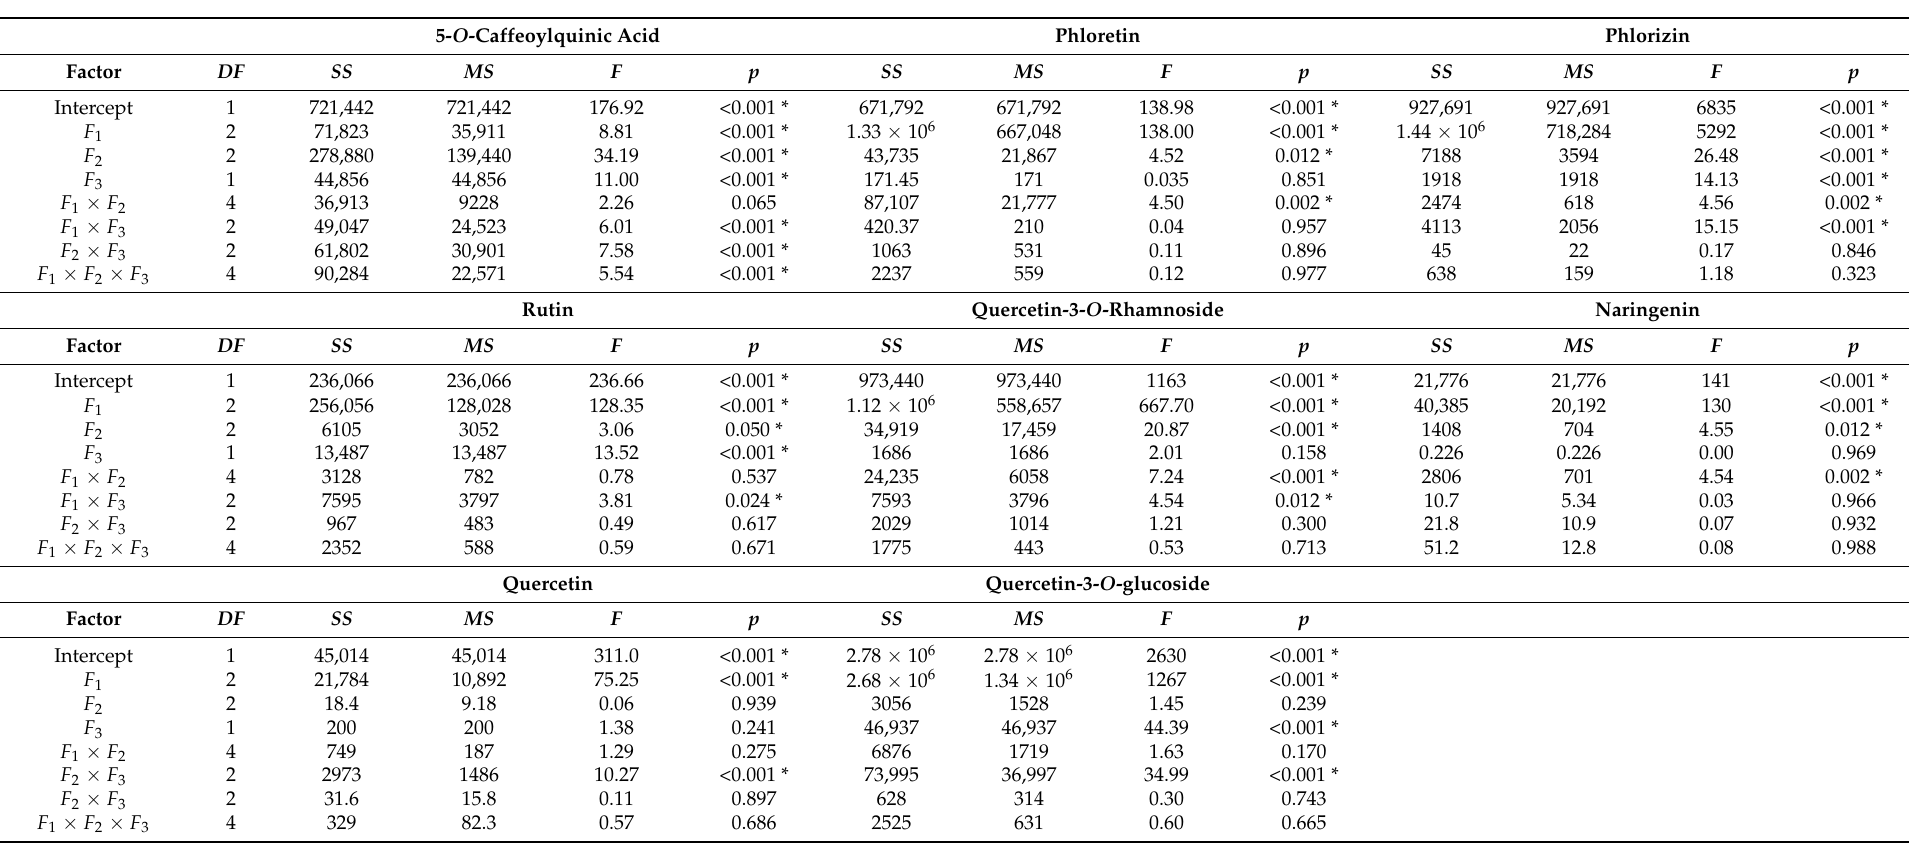
Table 1. Univariate test for the significance of the factor effects influencing the phenolic macro-component levels in the analyzed samples. DF —Degrees of freedom; SSs —Sum of squares; MSs —Mean squares. Factors: F 1 represents the three tissue types (mesocarp, peel, and leaf), F 2 describes the differences among the three apple cultivars (autochthonous, standard, and resistant), and F 3 corresponds to the years of production. Statistically significant results at p = 0.05 are denoted with